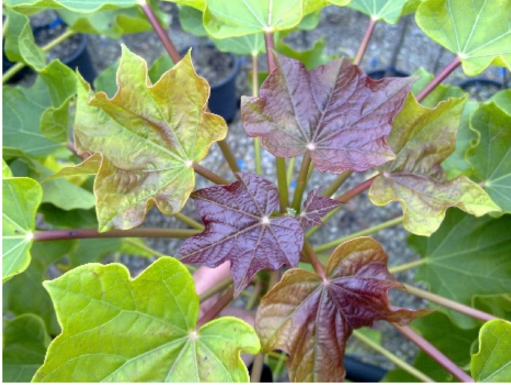
Figure 1. Particular of Jatropha curcas